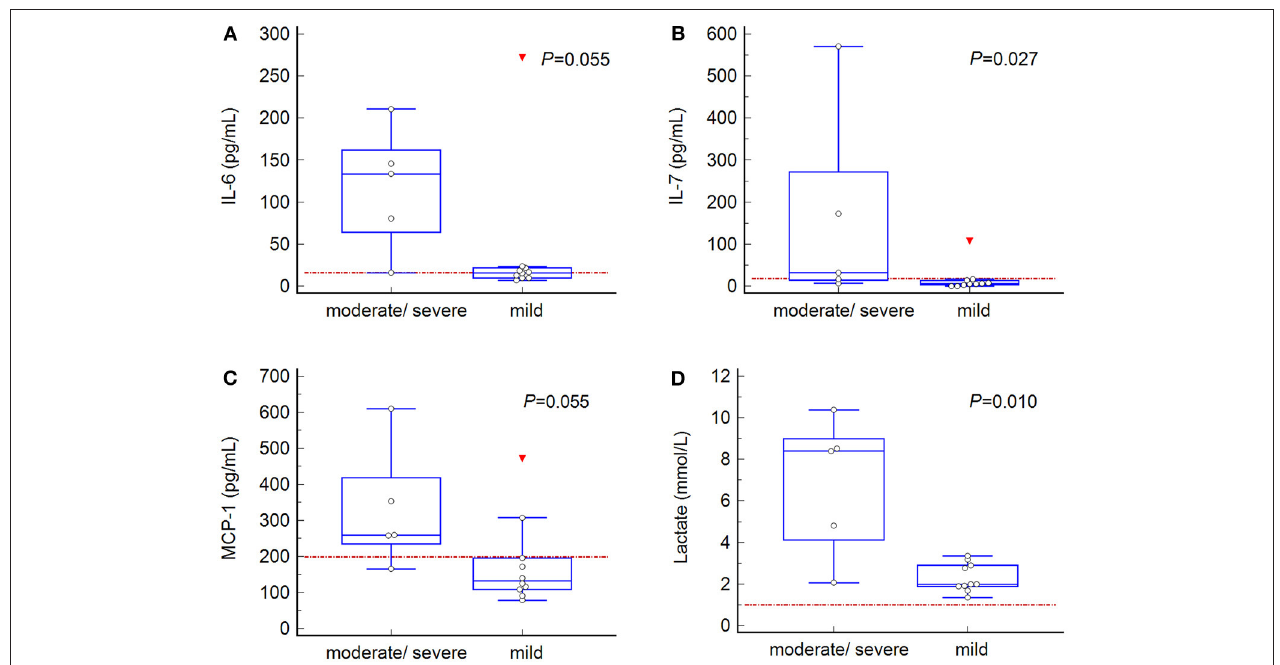
FIGURE 2 | Box-and-whisker plots of admission blood concentrations of markers, in which significant or borderline significant differences were found between values from dogs with mild ( n = 10) vs. moderate/severe ( n = 5) gastric wall changes. (A) interleukin (IL)-6; (B) IL-7; (C) monocyte chemotactic protein (MCP)-1; (D) lactate. Central box, values from the lower to upper quartile (25-75 percentile); middle line, median; horizontal line extends from the minimum to the maximum value; each displayed point represents the value of one dog; the red triangle represents an outlier. Red dotted line, median value of the control dogs. The P -value represents the statistical difference between dogs with mild versus moderate/severe gastric wall changes (Mann Whitney